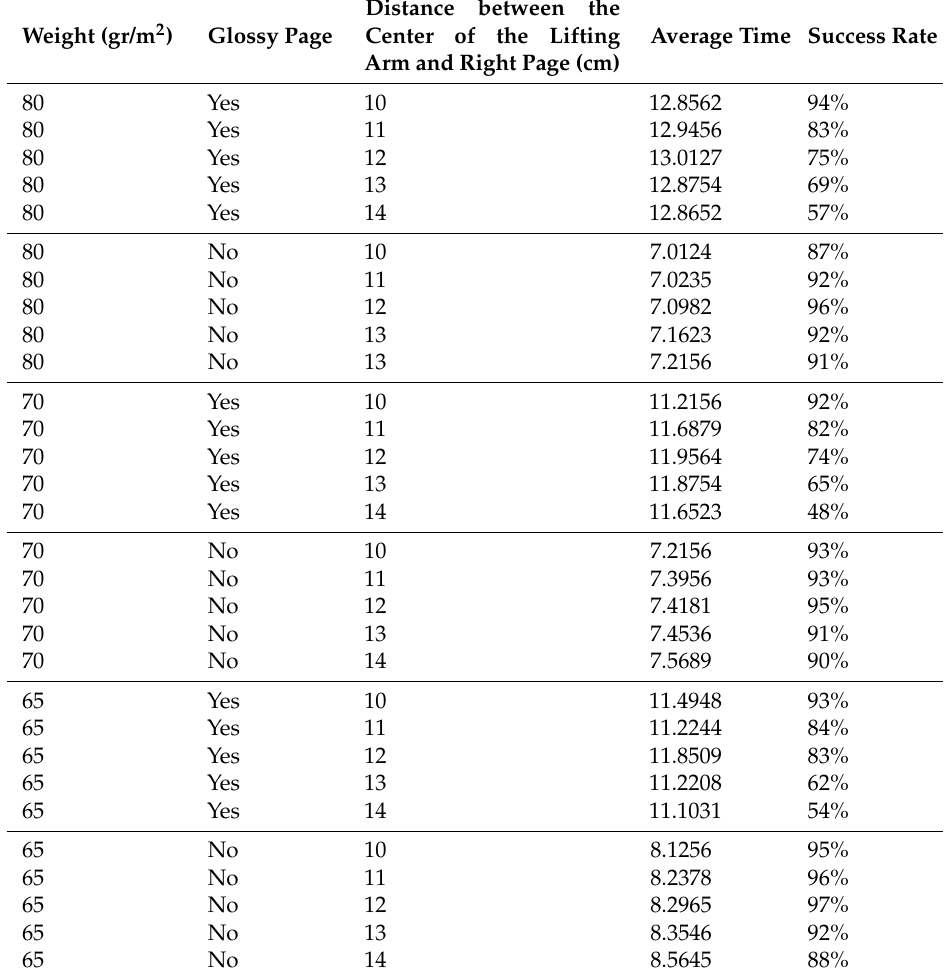
Table 1. Average time and success rate for different weight/gloss/distance configurations.